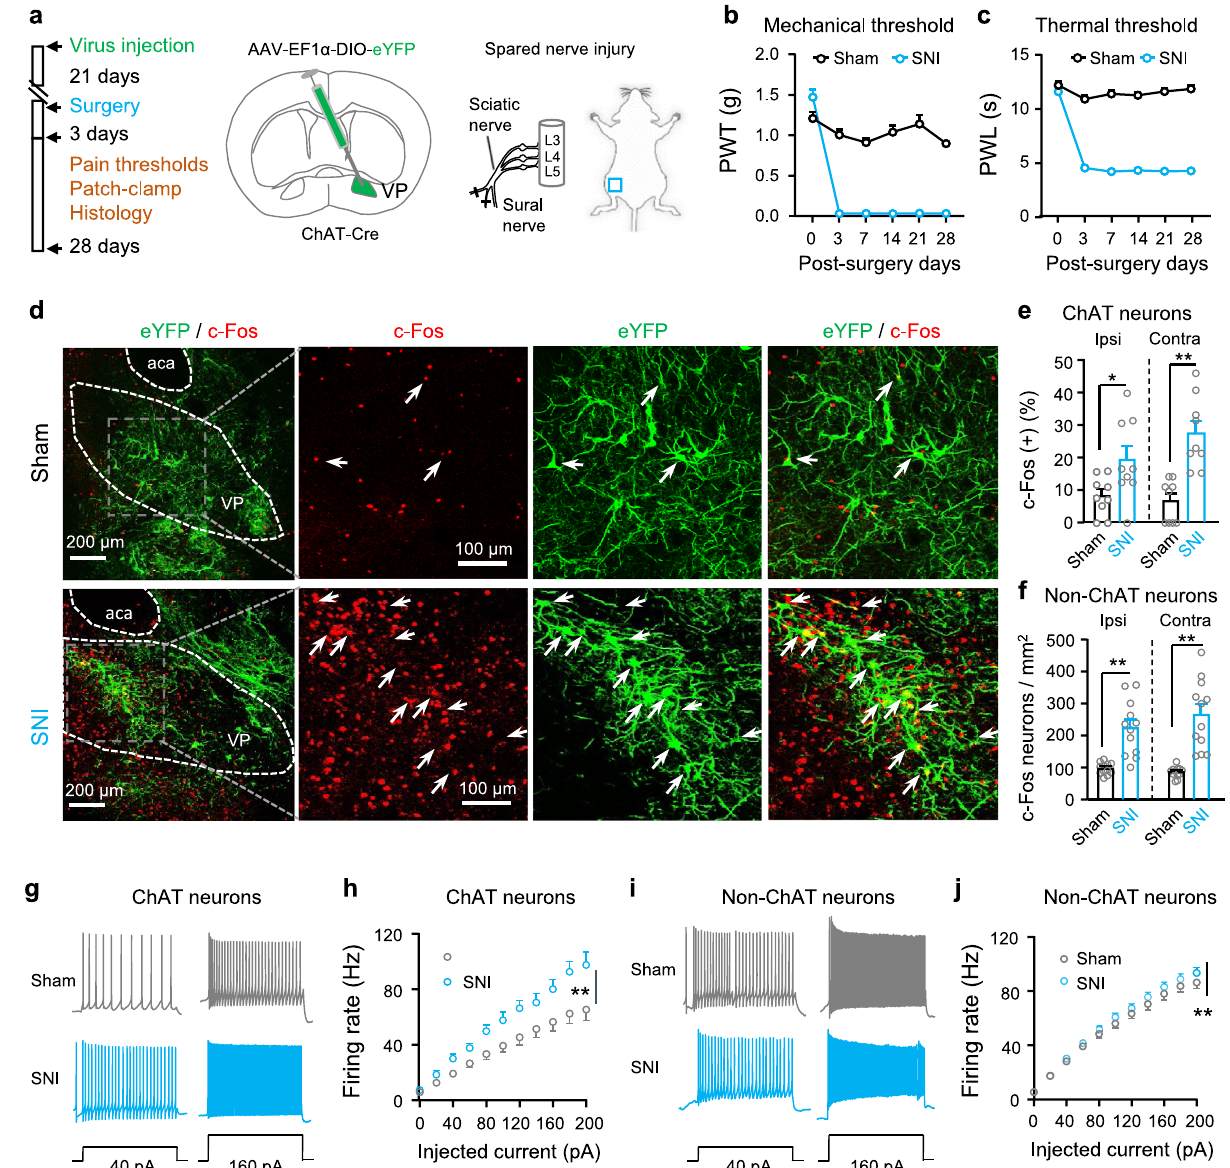
Fig.3|MicewithneuropathicpainexhibithyperactivityinChATandnon-ChAT neuronsintheVP.a SchematicdiagramforeYFP-labelingofVPChATneuronsand forsparedsciaticnerveinjury(SNI)ontheleftside. b Themechanicalthresholdon the lefthind paw wasmeasured with von Frey fi laments after surgery. Sham: n =15 mice; SNI: n =16 mice. Group: F (1, 29) =330.7, P <0.0001. Time: F (5, 145) =75.51, P <0.0001. c The thermal threshold on the left hind paw was measured with a plantar anesthesia tester after surgery. Sham: n =15 mice; SNI: n =16 mice. Group, F (1, 29) =688.2, P <0.0001. Time, F (5, 145) =86.09, P <0.0001. d – f Representative images (from contralateral VP) and summary showing c-Fos-positive neurons (red) in ChATneurons (eYFP-labeled,green) and non-ChATneurons (red only) in the VP on both sides. Sham: n =9 sections from fi ve mice; SNI: n =9 sections from fi ve